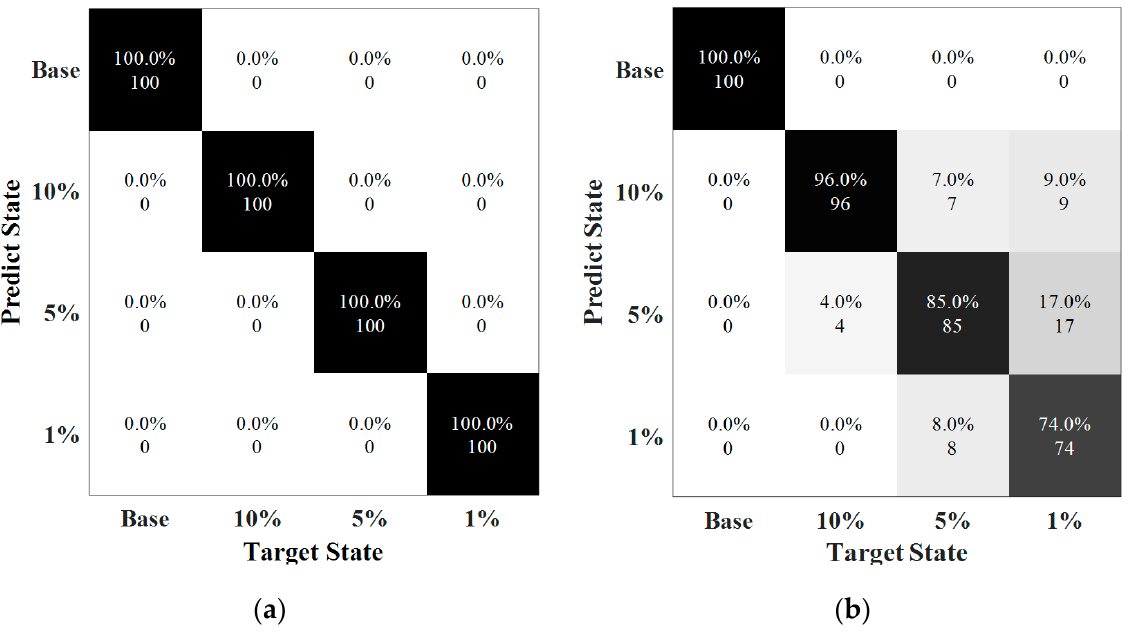
Figure 26. Confusion matrix associated with defect severity. ( a ) SNR = 80 dB (Accuracy = 100%). ( b ) SNR = 70 dB (Accuracy = 88.8%).